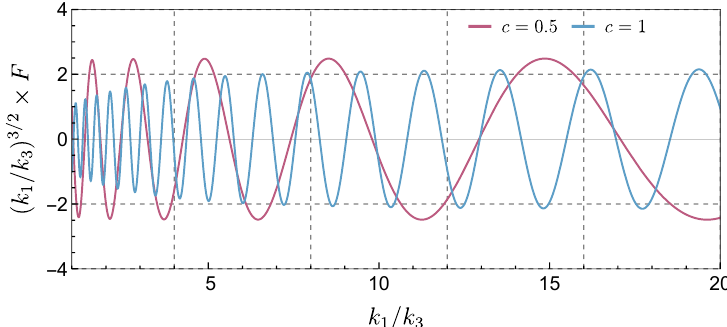
Figure 4. The oscillatory signal as a function of the momentum ratio k 1 /k 3 for M = 5 H and λ = 40 H . The two different curves correspond to c = 0 . 5 or M eff ’ 28 . 7 H (purple) and c = 1 or M eff = 5 H